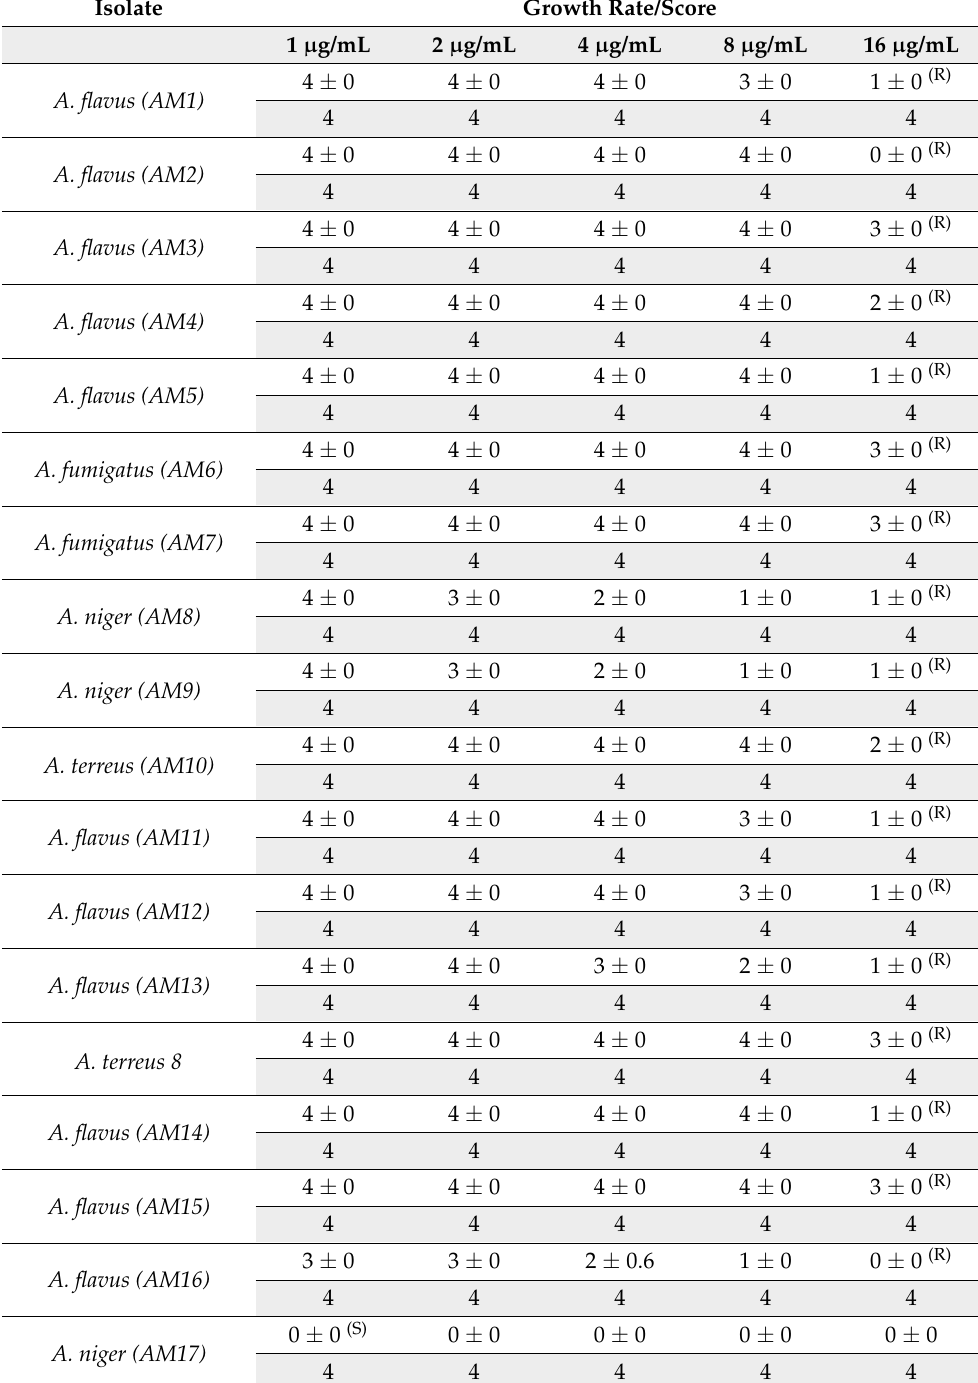
Table 7. Susceptibility of fungal species to different concentrations of Micafungin (broth microdilution method).